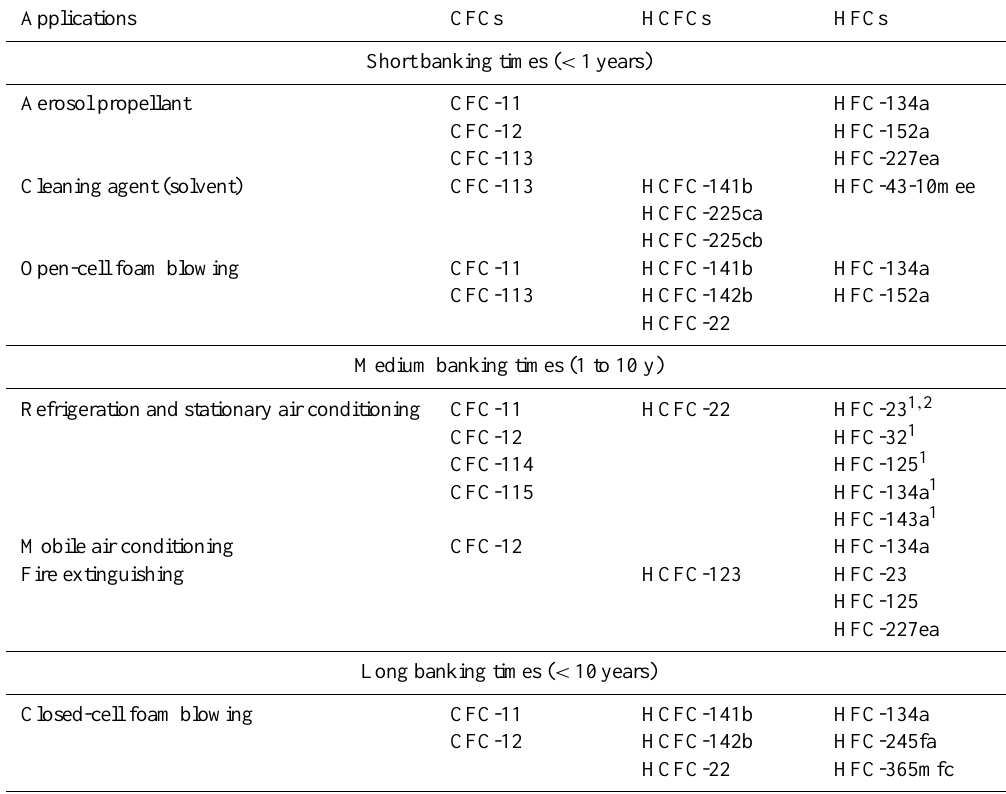
Table 1. Main applications of CFCs up to about 1990 and of HCFCs and HFCs currently. Applications